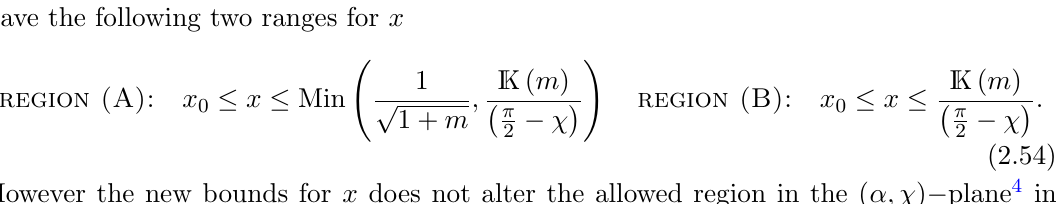
Figure 3. The inequality (2.55) holds in the light-blue region on the left of the black-line. and respects the bounds (2.50) in region (A) and (2.49) in region (B). Summarizing,